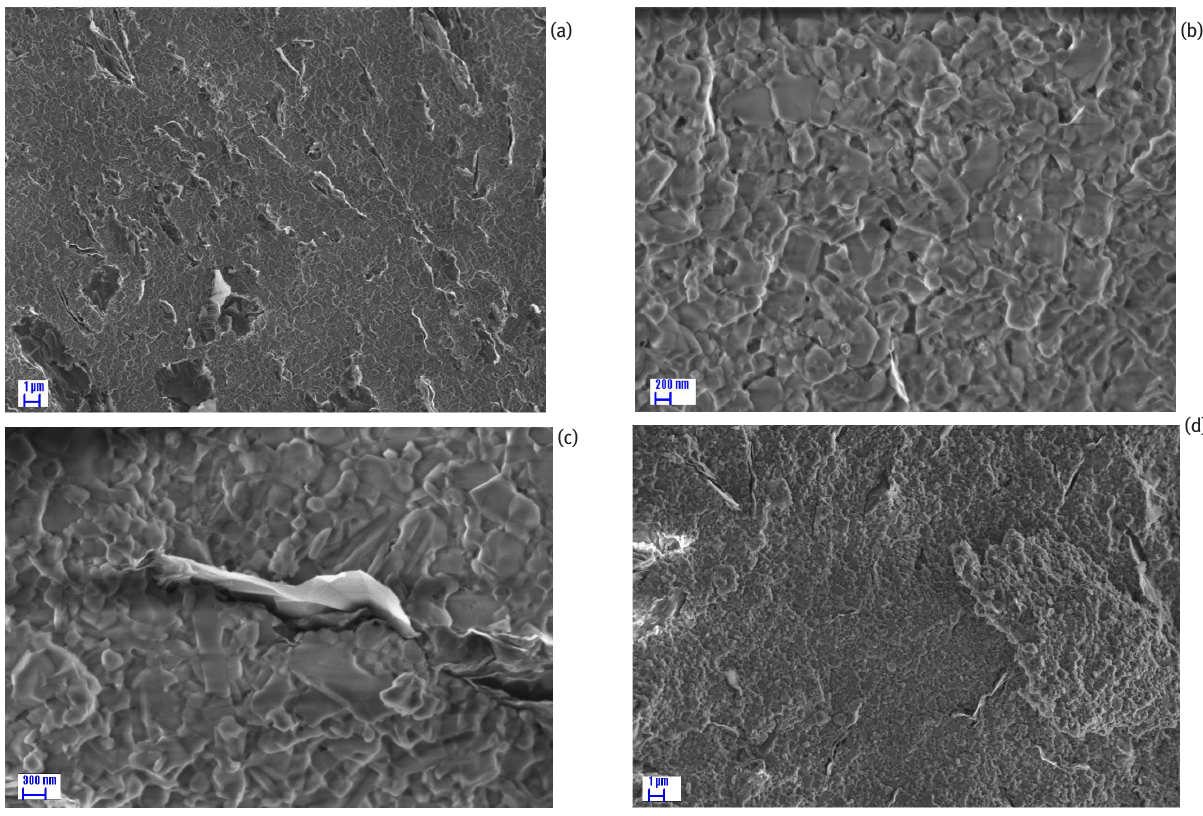
N /MLG composites (a) Fracture surfaces of the sample with 5 wt% MLG sintered at Figure 2: SEM micrographs of fracture surfaces of Si 3 4 1600°C/3 min. (b) Sample with1 wt% MLG content, sintered at 1500°C/10 min showing pores. (c) Sample with 3 wt% MLG, sintered at 1600°C/10 min revealing β grains between α- phase. (d) Samples with 3 wt% MLG, sintered at 1500°C/3 min showing the pores along the graphene- matrix